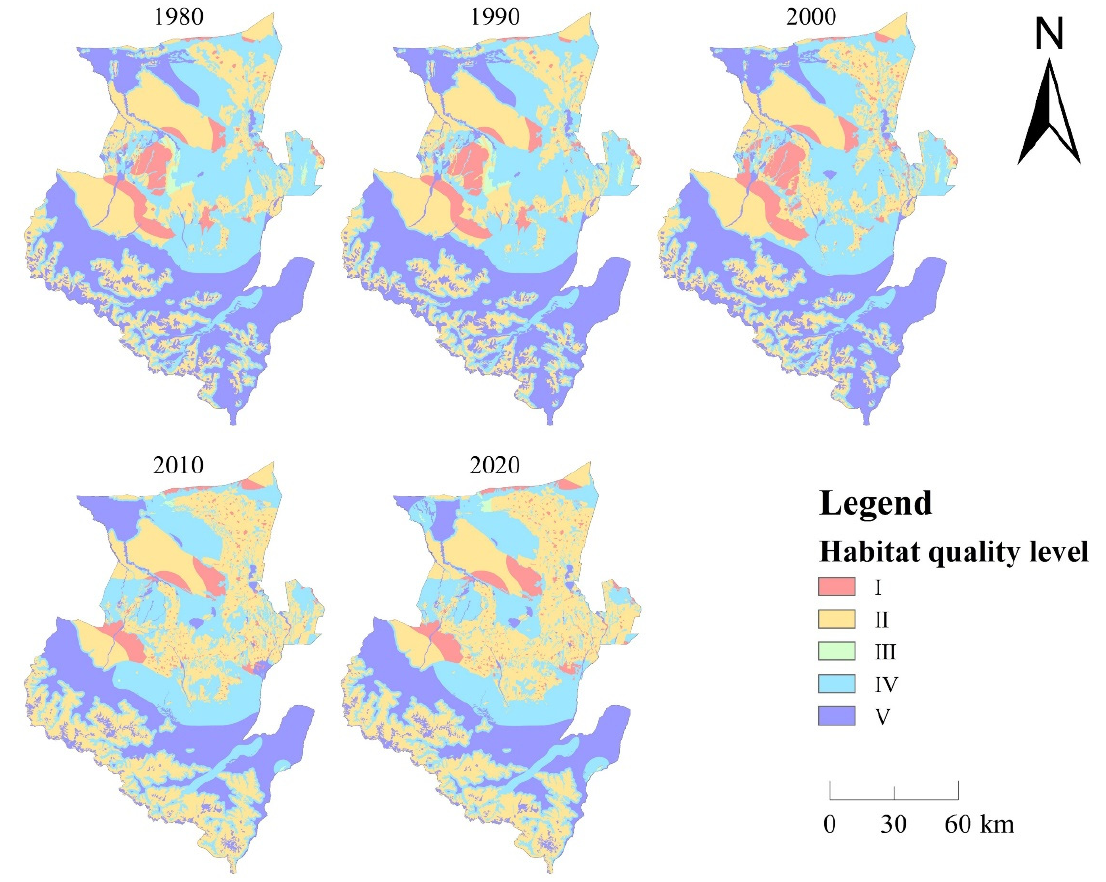
Figure 6. The spatial distribution of HQ of Wusu.